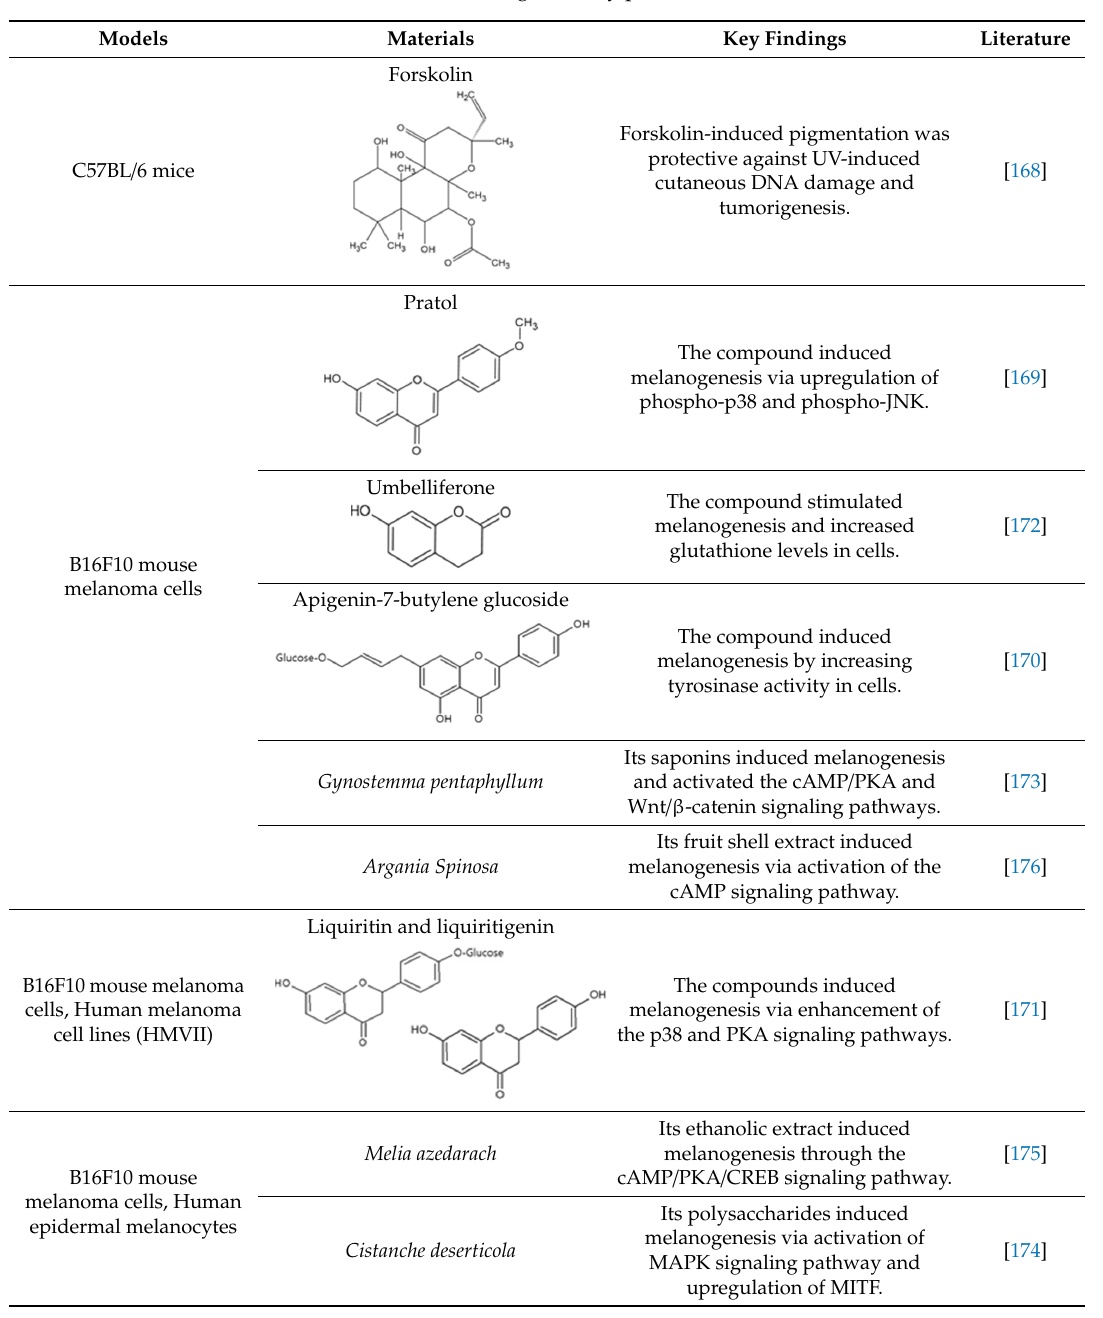
Table 4. Induction of melanogenesis by plant-derived materials.